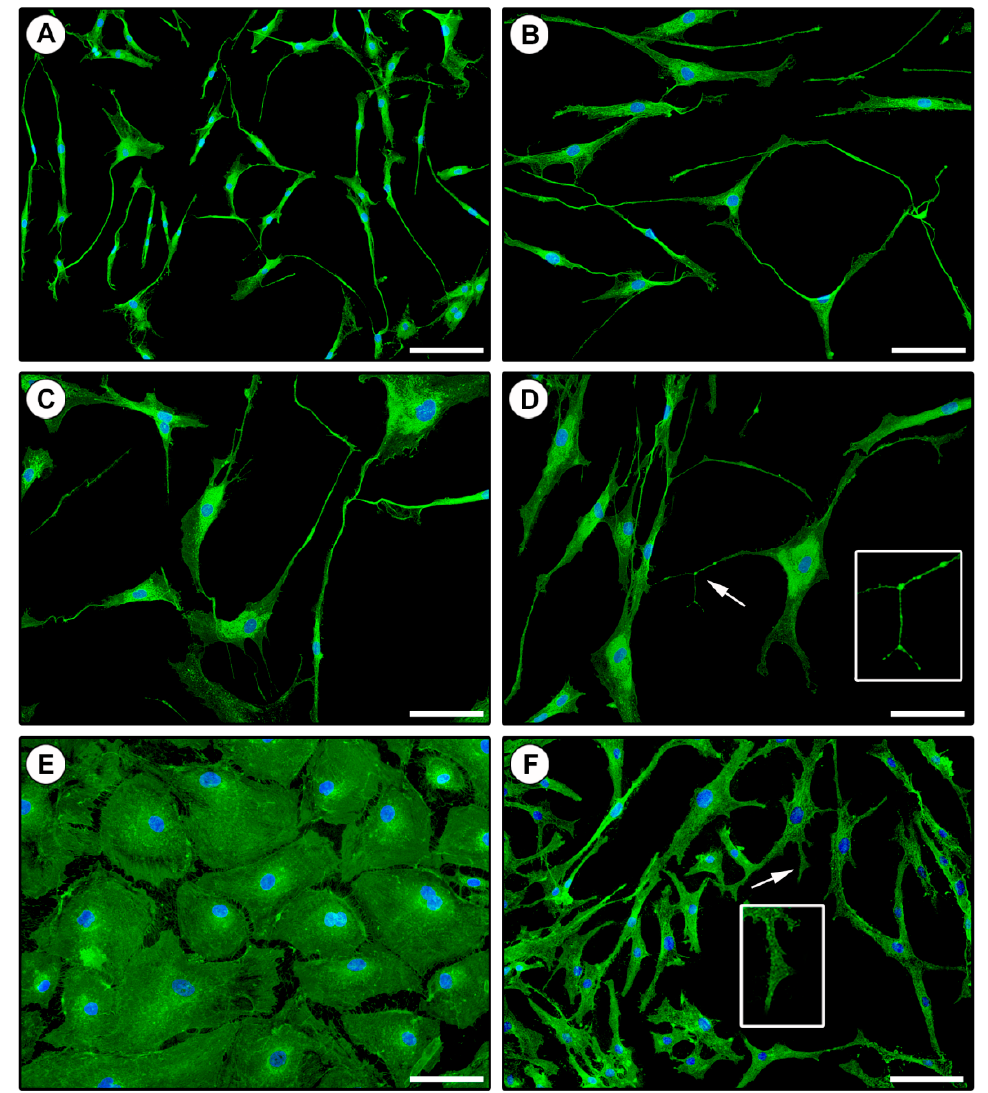
Figure 3. Morphologic assessment of in vitro cultured CD31 − /CD34+, CD31+, and CD31 − /CD34 − immunomagnetically selected cells by staining of the cell membrane with fluorescent wheat germ agglutinin. ( A–D ) Representative fluorescent microscopic images of CD31 − /CD34+ isolated cells exhibiting the distinctive telocyte morphology, with a small cell body and long cytoplasmic prolongations (i.e., telopodes) presenting a moniliform aspect conferred by the alternation of slender segments (podomers) and bead-like dilated portions (podoms). Telocytes are heterogeneous in the shape of their cell body that gives rise to a variable number of telopodes. ( D ) A higher magnification view of the telopode pointed by the arrow is shown in the inset. ( E ) Representative fluorescent image of CD31+ isolated cells with the characteristic polygonal cobblestone-like morphology of endothelial cells. ( F ) Representative fluorescent image of CD31 − /CD34 − isolated cells presenting the typical spindle shape of fibroblasts, with shorter and thicker non-moniliform cytoplasmic prolongations. The fibroblast prolongation pointed by the arrow is shown at higher magnification in the inset. Nuclei are counterstained in blue with 4 ′ ,6-diamidino-2-phenylindole (DAPI). Original magnification: ×10 ( A ), ×20 ( B – F ). Scale bar: 200 µm ( A ), 100 µm ( B – F ).